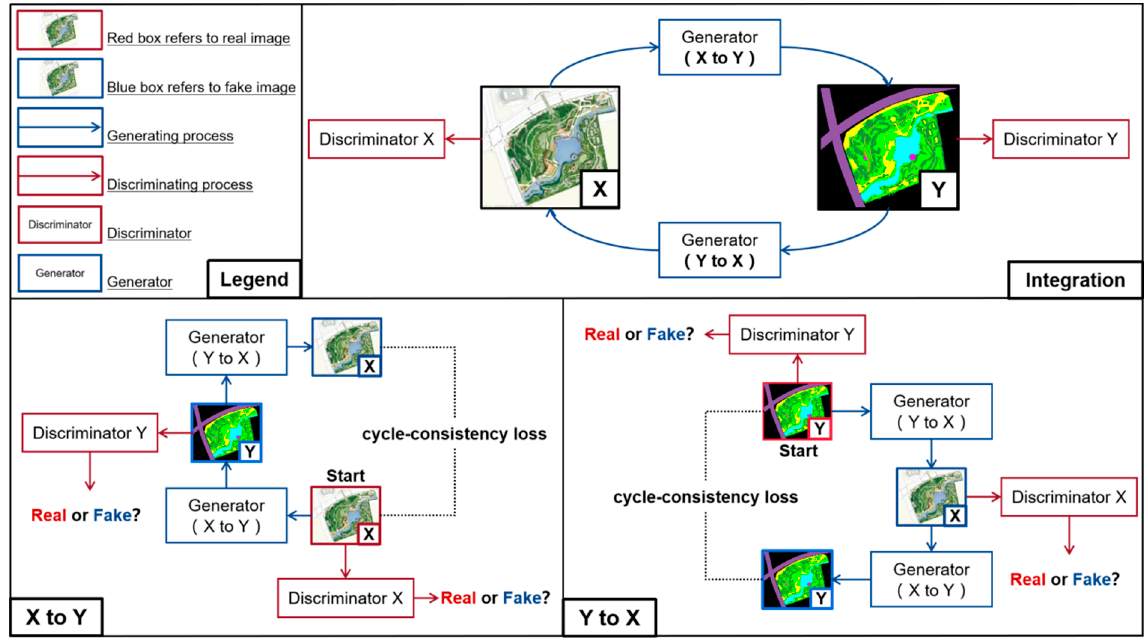
Figure 5. The overall framework of